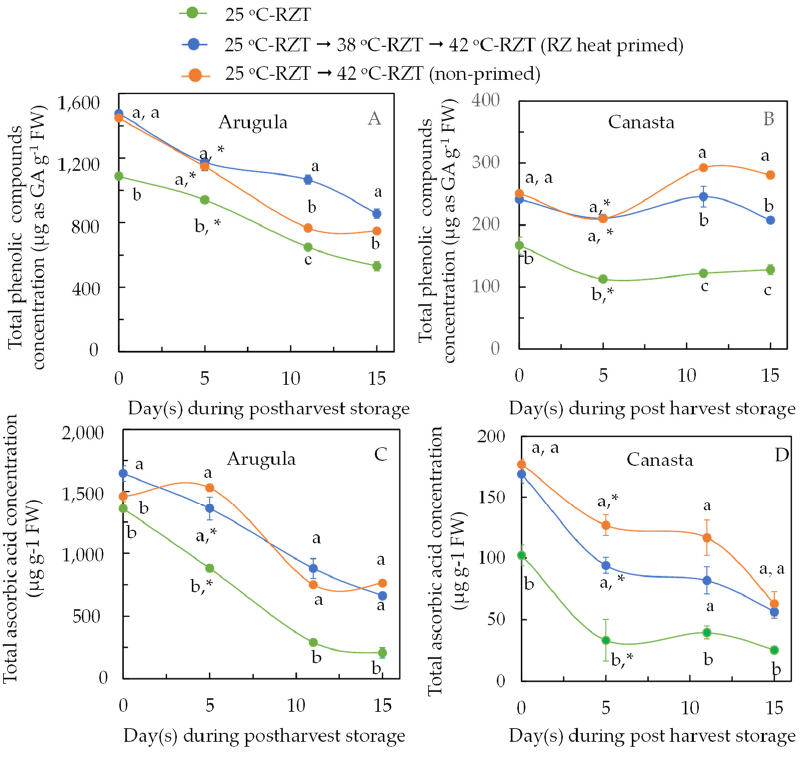
Figure 7. Total phenolic compounds concentration ( A , B ) and total ascorbic acid concentration ( C , D ) of Arugula ( A , C ) and Canasta ( B , D ) at harvest (36 DAT or 0 day after harvest) and during postharvest storage. The vertical lines through the means represent standard errors ( n = 4). Different lowercase letters are statistically different ( p < 0.05, Tukey’s multiple comparison test) among different RZT treatments. Samples from each postharvest day were analyzed separately. For the changes of total phenolic compounds and ascorbic acid between 0 day (at harvest) and 5 days after postharvest storage, means with an asterisk (*) indicate significantly different ( p < 0.05) using Dunnett’s procedure. Refer to Section 4.2 for further details on different RZT treatments.